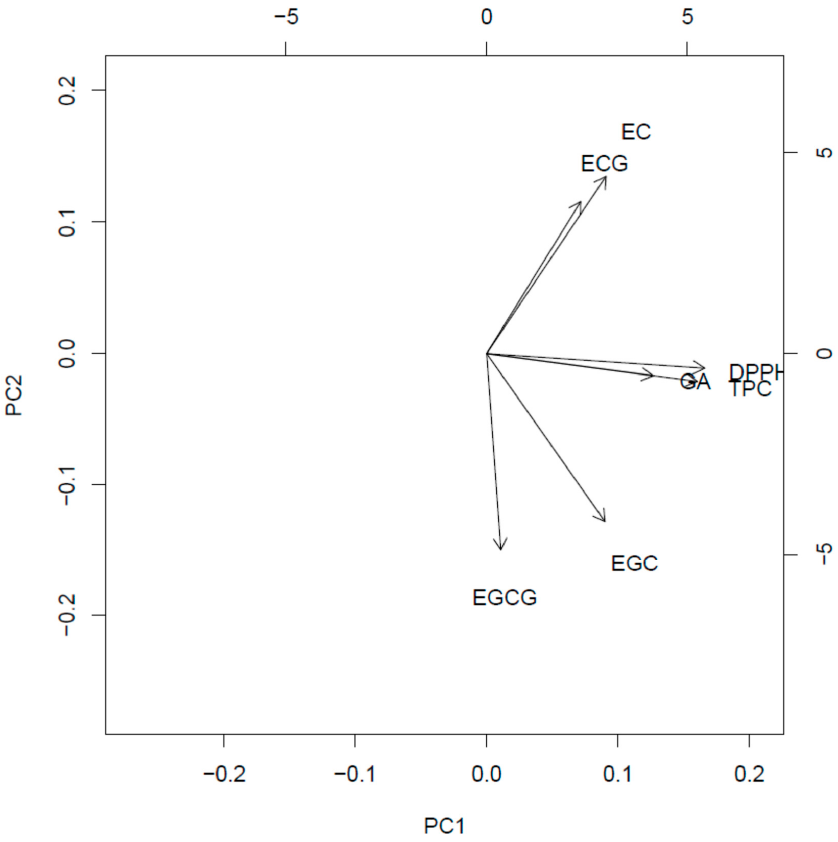
Figure 2. The loadings of first two components depicted on Figure 2. For explanations, see